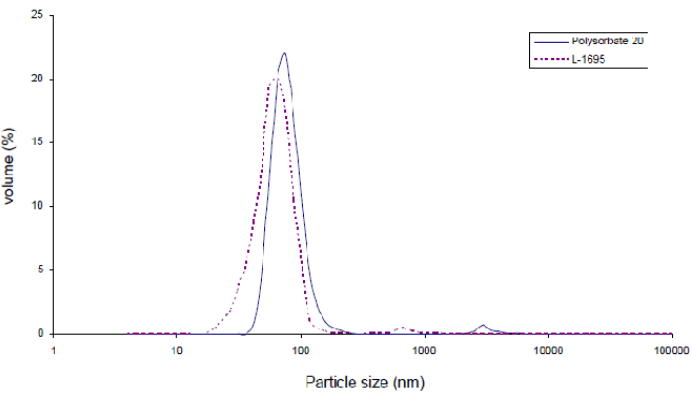
Figure 1. Particle size distribution of astaxanthin nanodispersions prepared with Polysorbate 20 and